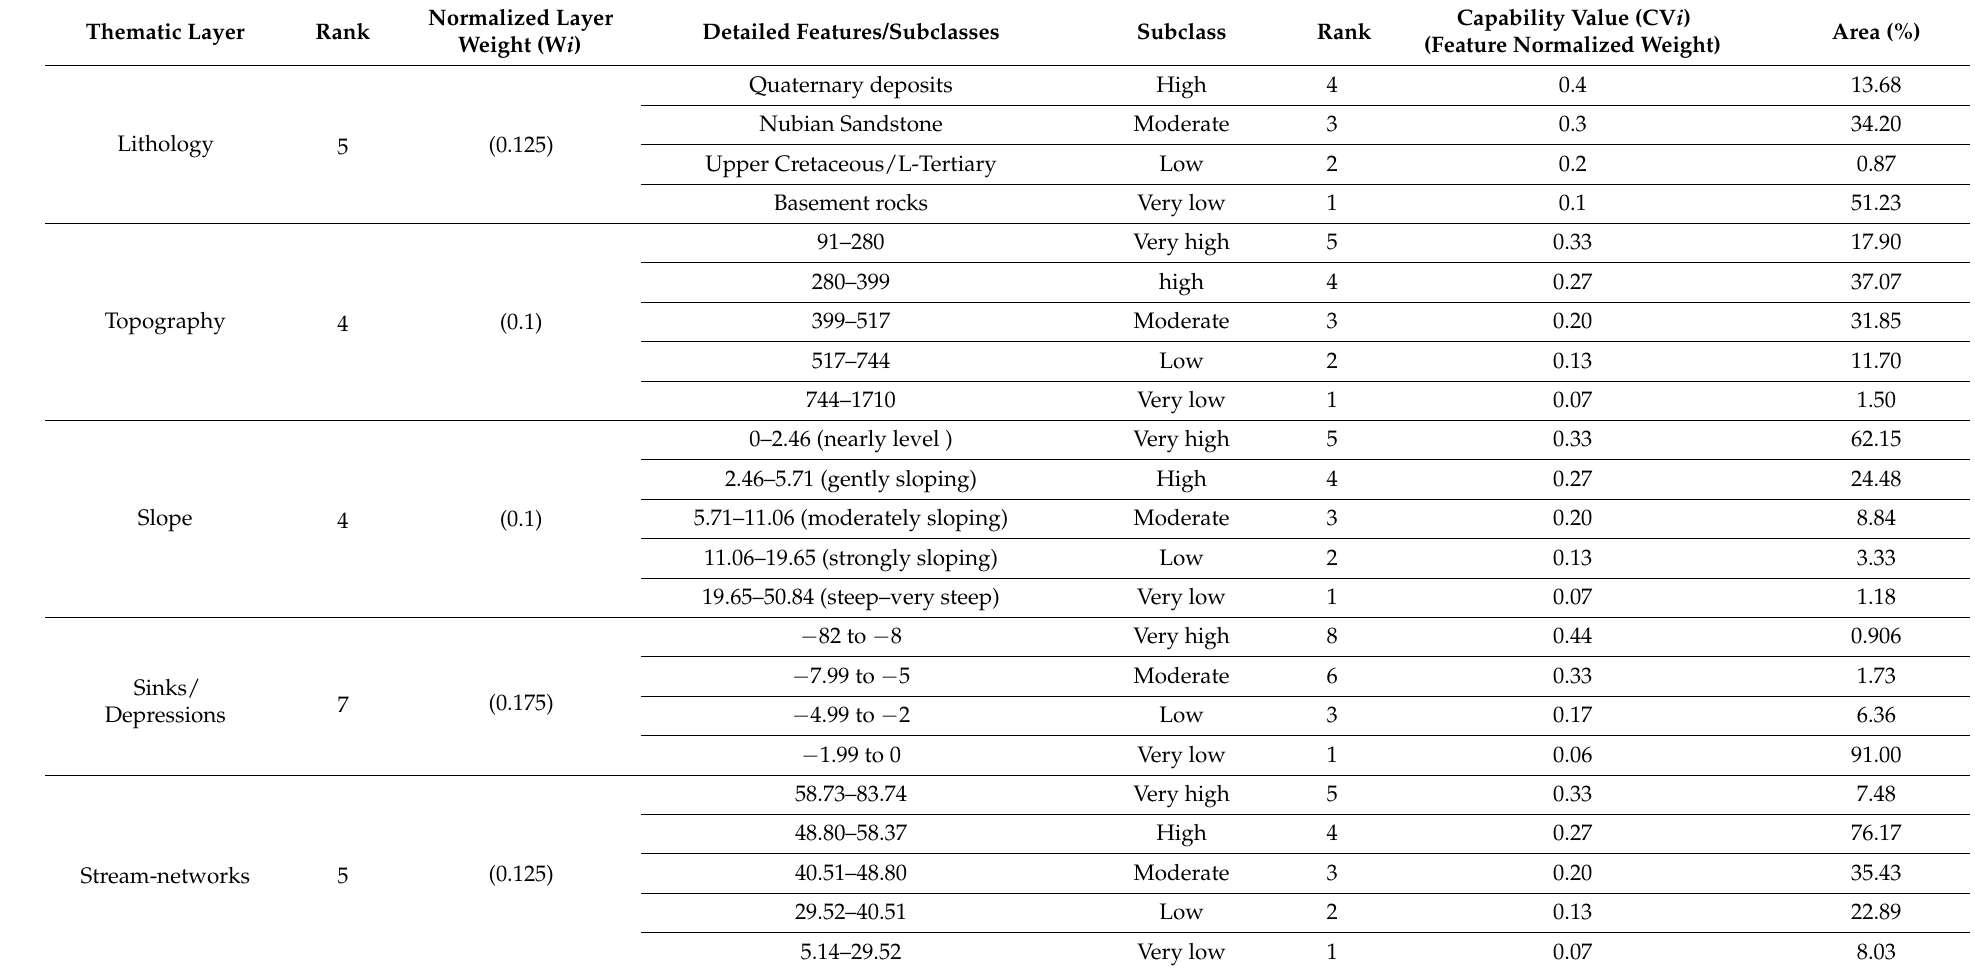
Table 1. Thematic map weight and capability value of the thematic